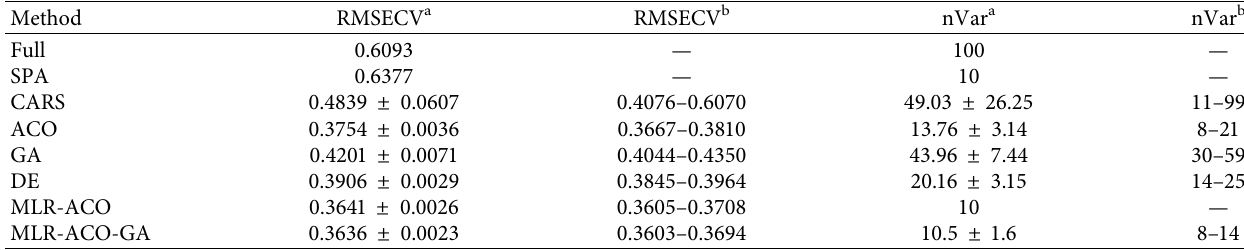
Table 1: Te results of diferent methods on the wheat protein